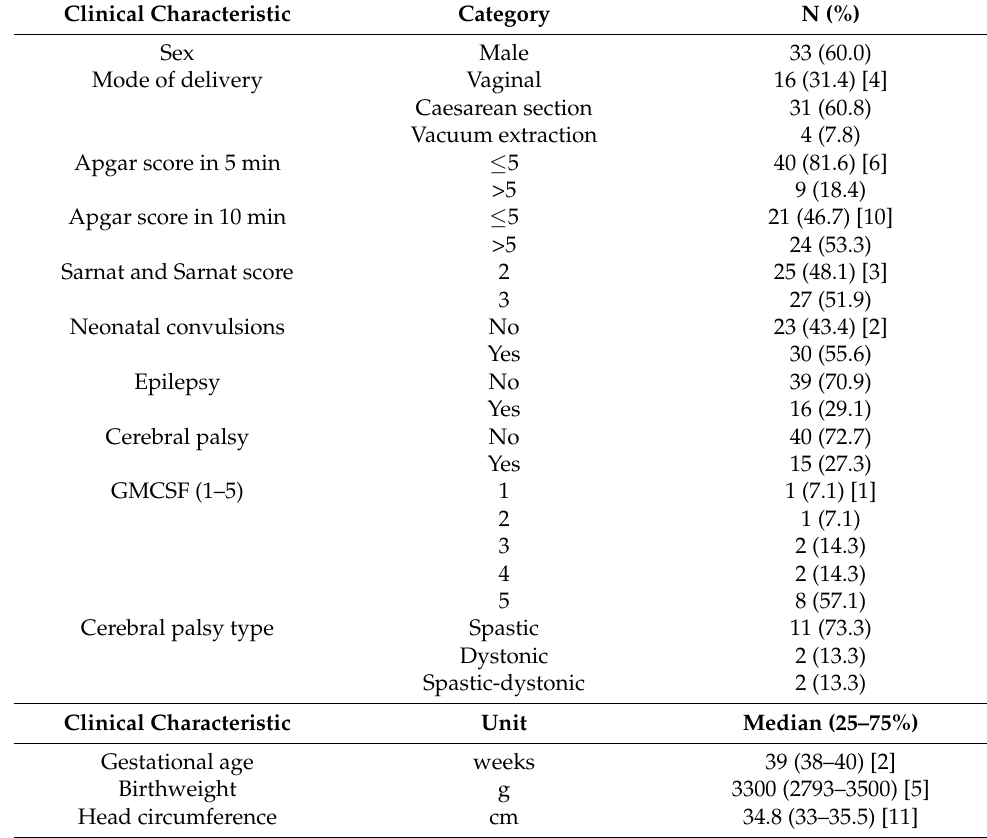
Table 1. Clinical characteristics of 55 newborns with